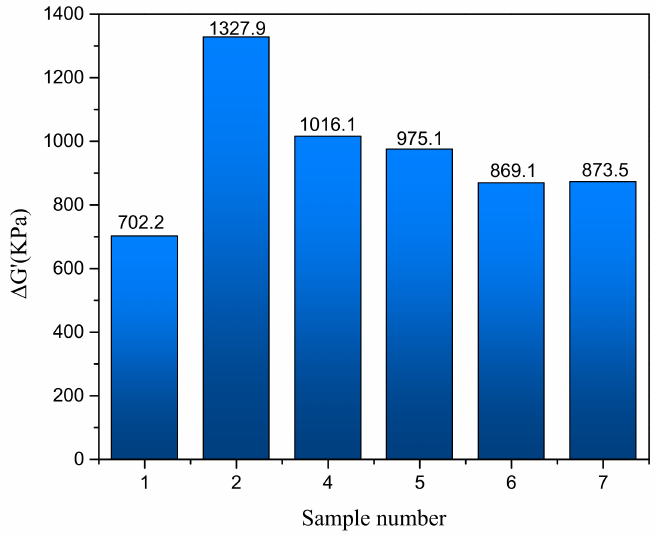
Figure 4. RPA results of the